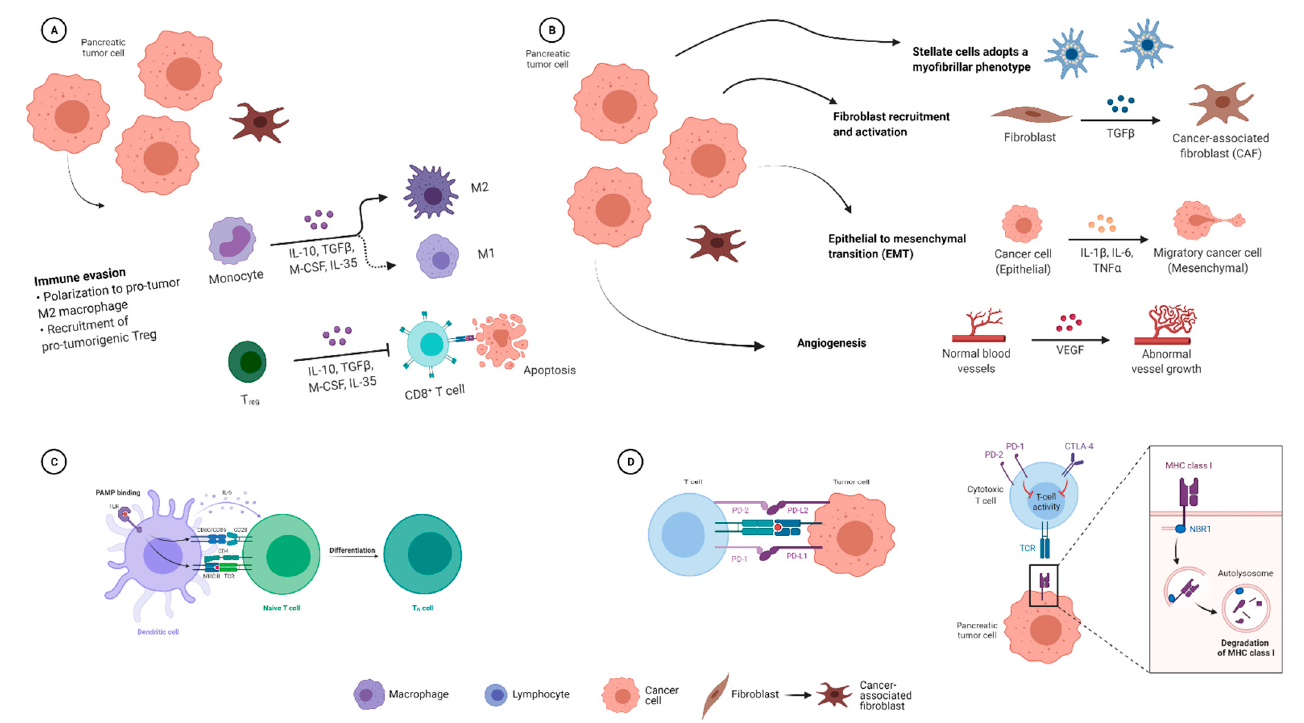
Figure 2. Overview of the immunosuppression in PDAC, associated with the presence of tumour- promoting immune cells. ( A ) Pancreatic tumour cells, produce an immune phenotype rich with an increase in infiltrates FOXP3, Tregs and M2 polarised macrophages that lead to poorer prognosis. ( B ) Pancreatic cancer cells promote angiogenesis and epithelial to mesenchymal transition (EMT). EMT is loss of epithelial e-cadherin and increase in mesenchymal Vimentin allows cancer cells to become more mobile and metastatic. Stellate cells are responsible for the profound desmoplasia observed in PDAC. Cancer-associated fibroblasts (CAFs) aid tumour growth, local invasion and metas- tasis. ( C ) Dendritic cells (DC) are antigen presenting cells (APCs) that generate tumour-protective T cells within the TME of PDAC. ( D ) One of the strategies used by PDAC is to bypass the immune surveillance by the misuse of immune checkpoints in order to escape immune recognition. Cytotoxic T lymphocyte-associated antigen 4 (CTLA-4 or CD152) and programmed cell death protein 1 (PD-1 or CD279) are co-inhibitory receptors of T cell receptor (TCR) signalling. Immune checkpoints inhibit T-cell activation. PD-L1 has been reported to be overexpressed in PDACs, and this overexpression correlates with worse prognosis of the